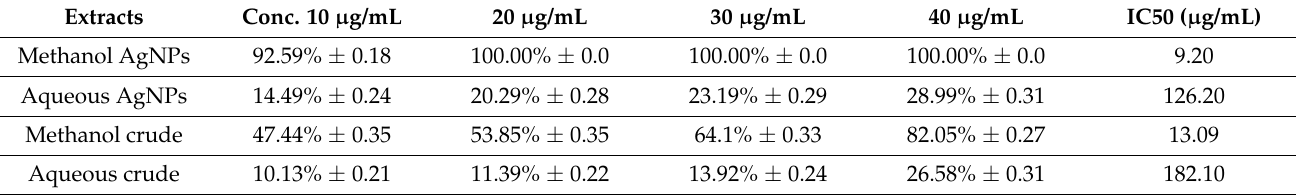
Figure 5. Docking complexes of the bioactive compounds from C. papaya leaf extracts against DENV-2 NS5 protein; ( a ) 5,7- Dimethoxycoumarin, ( b ) E-Chlorogenic acid, ( c ) Protocatechuic acid, ( d ) Quercetin, and ( e ) Kaempferol. Table 3. Percentage viral inhibition of the different C. papaya leaf